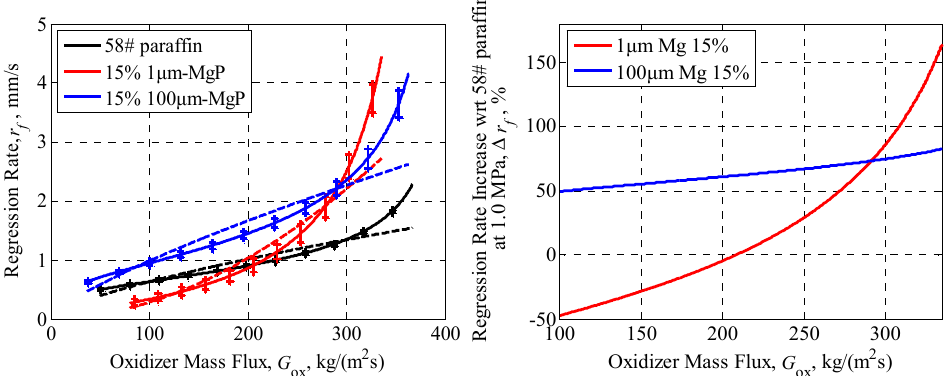
Figure 12. r f vs. G ox ( left ) and percentage increase in regression rate ( right ) of magnesium particles/paraffin composite fuels, at 1 MPa, pointing out a strong particle size effect. The dotted lines are fitting curves according to the semi-empirical formula: 𝑟(cid:4662) (cid:3033) = 𝑎 𝑟 𝐺 oxn 𝑟 ( 𝑡 ) .